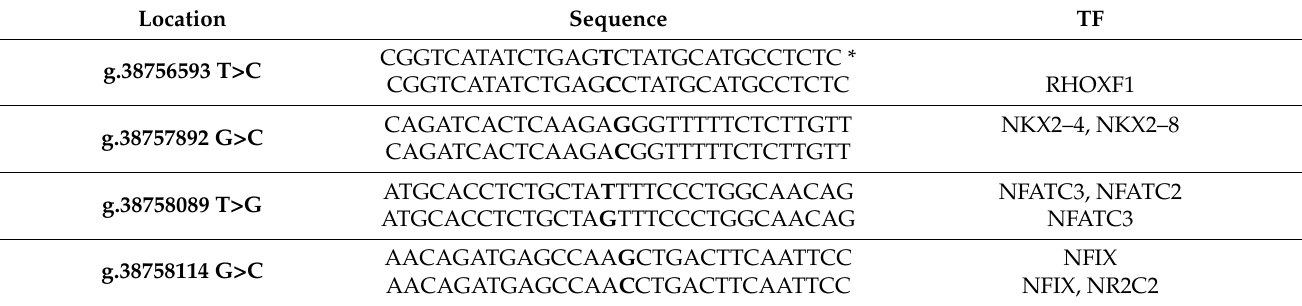
Figure 2. Significant association analysis between SNPs and BFT. * Significant difference in the association analysis between two genotypes and 6–7 rib backfat thickness at p < 0.05. Table 2. Changes of TFs caused by SNPs in promoter regions.